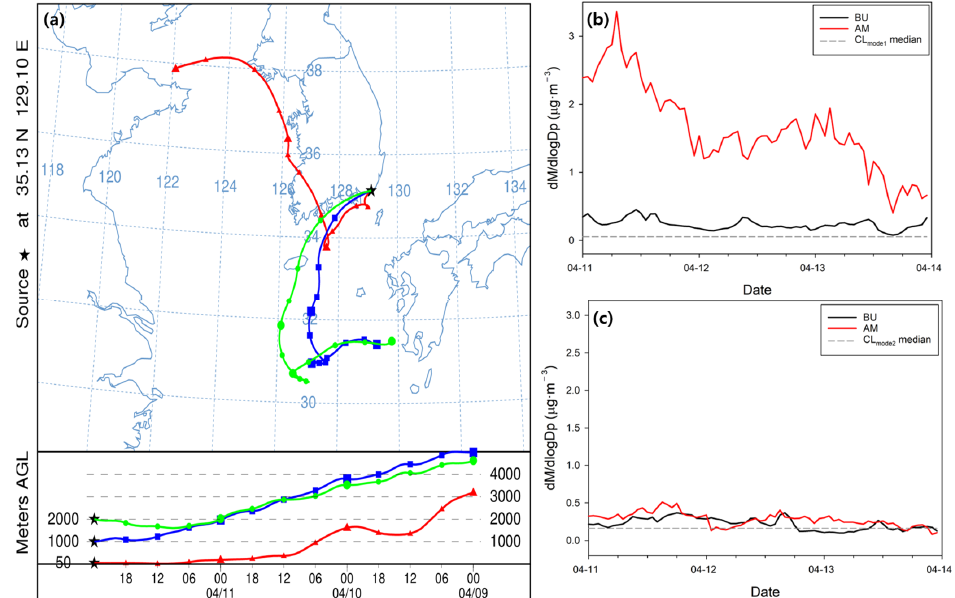
Figure 10. ( a ) Backward trajectory of air masses at 0000 UTC 12 April 2009 in Busan. Time series of aerosol mass concentrations in ( b ) Mode 1 and ( c ) Mode 2 at Busan (black line) are presented with those of Anmyeondo (red line) for 9–12 January 2009. The dashed lines are the median aerosol mass concentration for the CD cases in Modes 1 and 2, respectively.